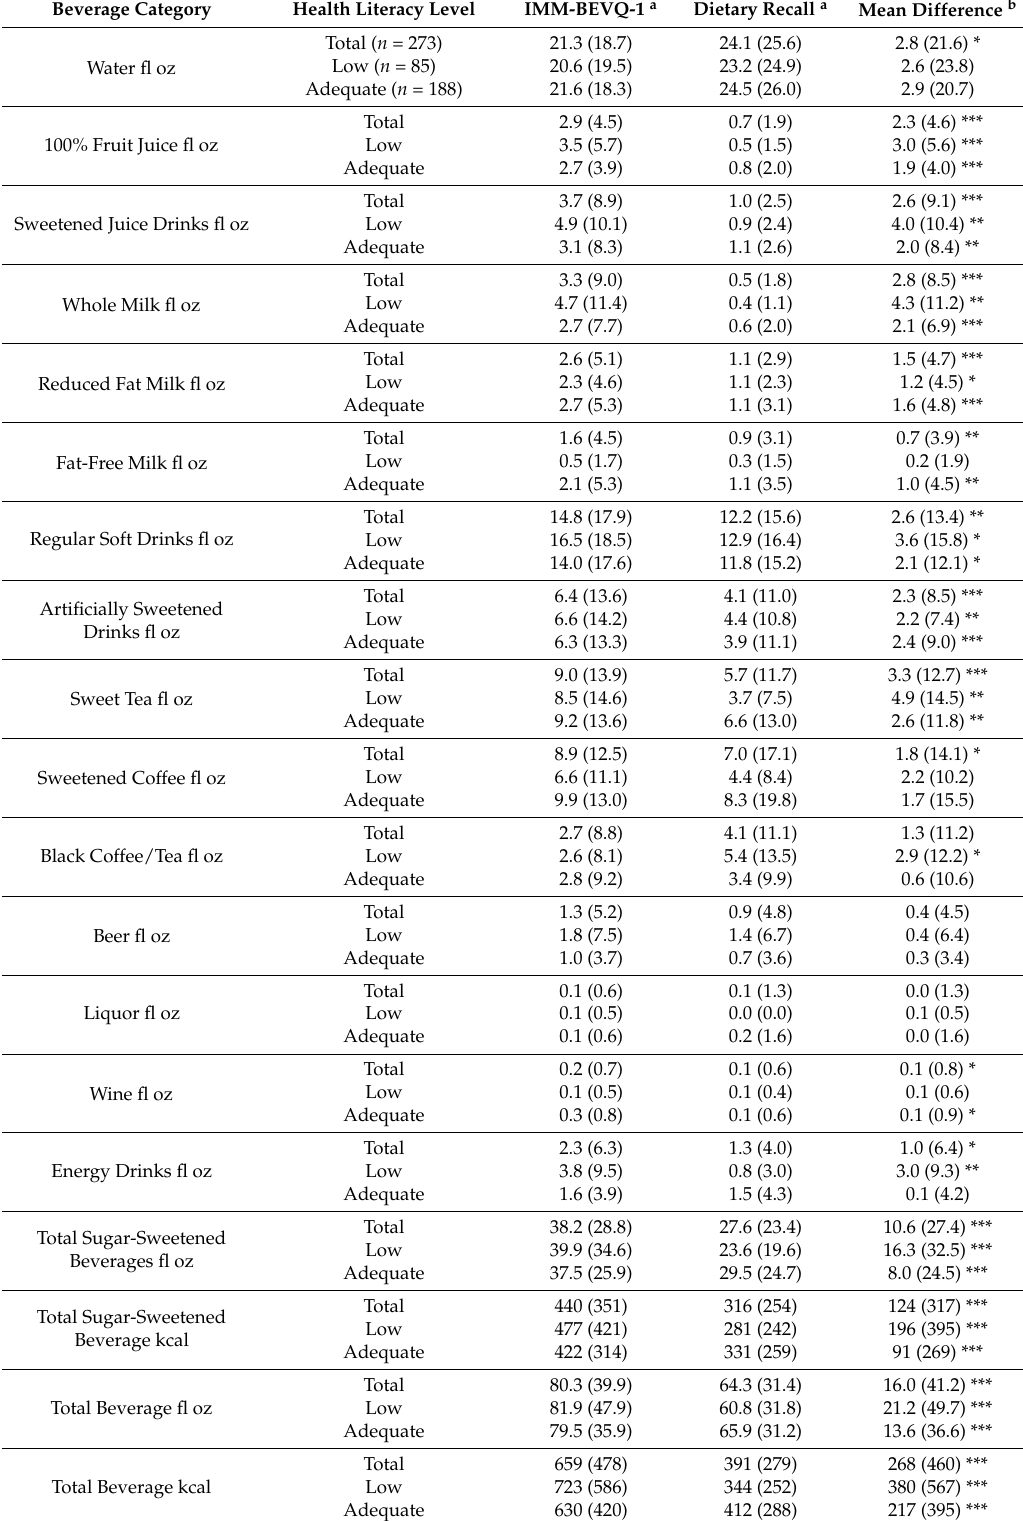
Table 2. Comparative validity of an interactive multimedia beverage intake questionnaire (IMM-BEVQ): Comparison to dietary recalls at baseline data